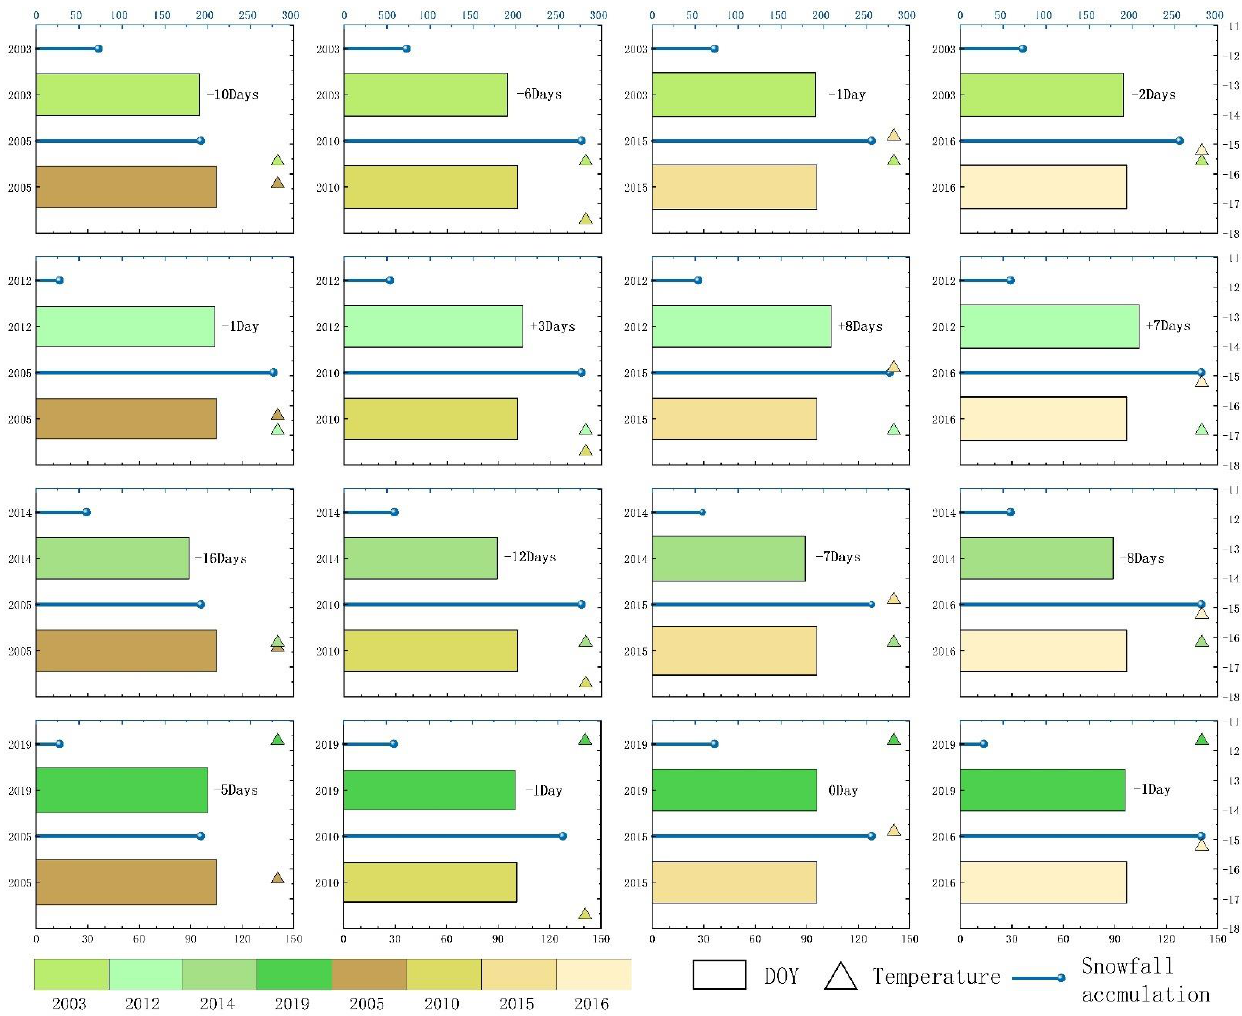
Figure 5. The forest land start of the season (SOS) date by year in the Sanjiang Plain. The left axis is the year, the right axis is the temperature (°C), the upper axis is the snowfall accumulation (mm), and the lower axis is the DOY of each year’s SOS. Rectangles represent the DOY of SOS, triangles represent the temperature, and lines represent the snowfall accumulation.